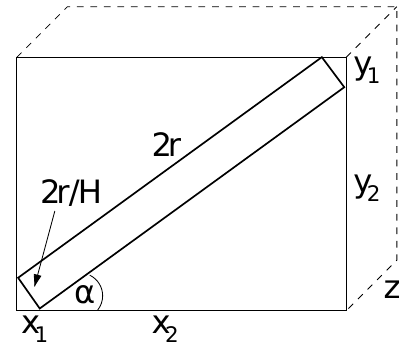
sin α , x 2 = 2 r cos α , H